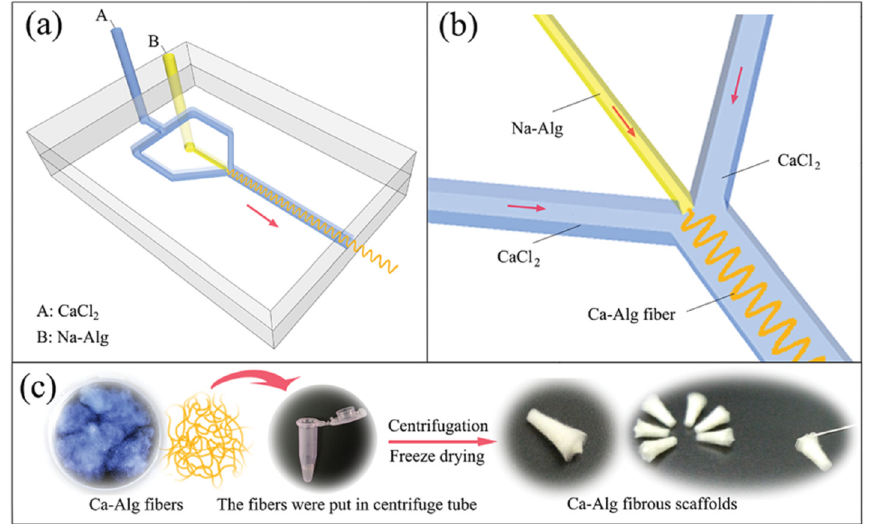
Figure 5. The schematic diagram shows the process of fabrication of Ca-Alg fibrous scaffolds using microfluidic spinning technology: ( a ) structure diagram of a microfluidic chip, ( b ) enlarged view of the crossing section of A and B fluids, ( c ) preparation process of Ca-Alg fibrous scaffolds. Red arrows in ( a , b ) correspond to the flow direction. Reprinted from